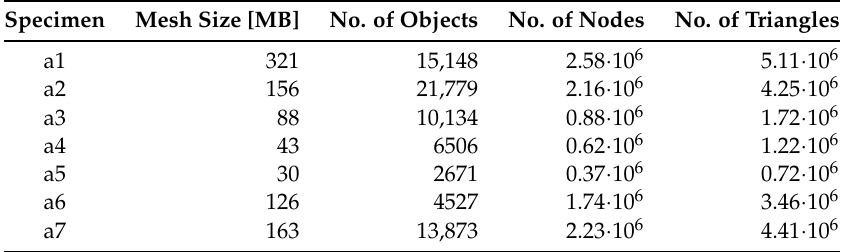
Table 3. Comparison of memory requirements and parameters of the surface meshes of defects identified in different specimens. The size of the voxel file was 3 GB for each specimen.